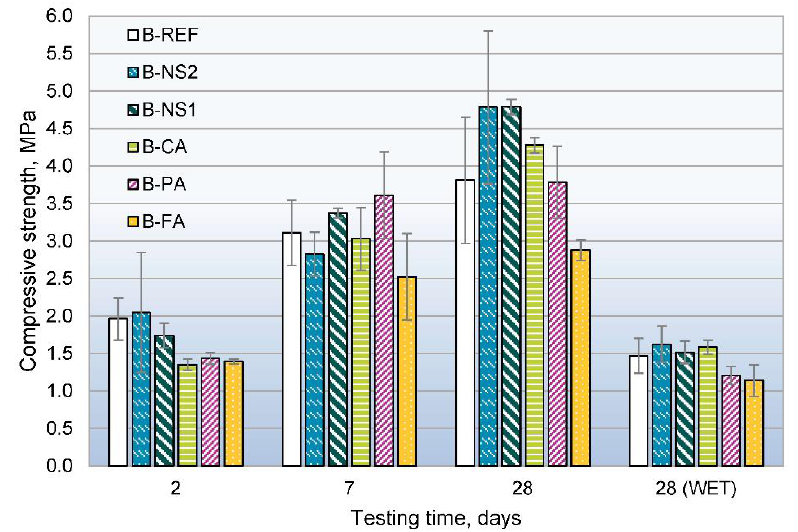
Figure 7. Compressive strength of the bio-composites. After 7 days, the strength of all the samples was within the median error limits 2.5–3.6 MPa. For 28 days, both NS1 and NS2 noticeably increased the strength of bio- composites from 3.8 to 4.8 MPa, compared to B-REF. CA and PA showed similar strengths